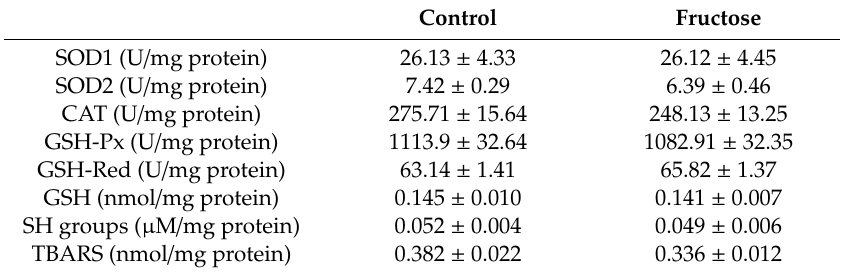
Comparisons between fructose-fed and control rats were made by unpaired Student’s t -test. Values are expressed as the mean ± SEM ( n =